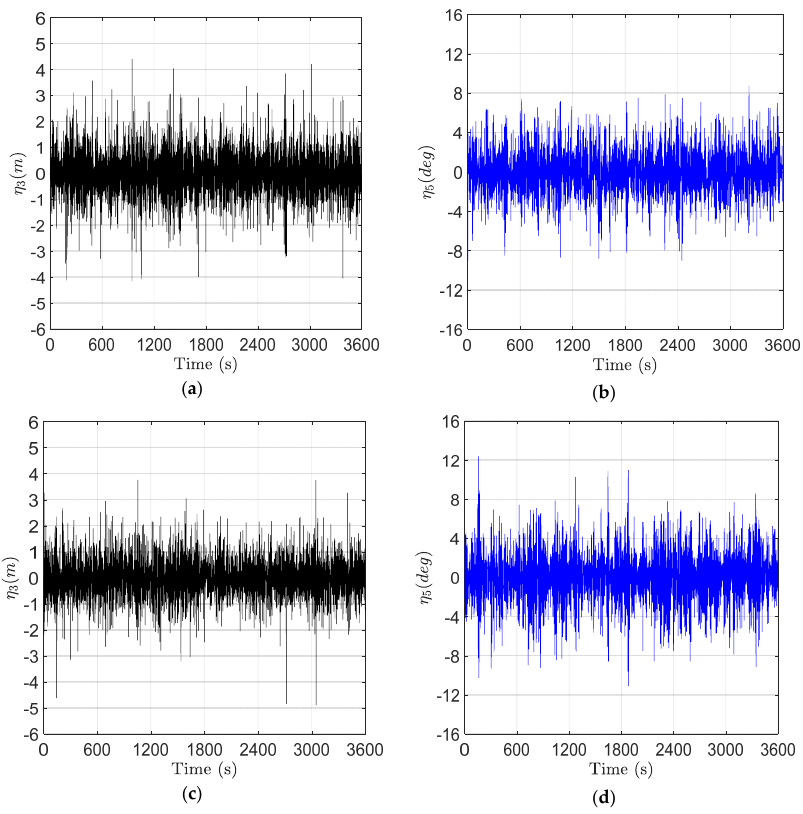
Figure 6. Data collection, motions amplitude: ( a ) Heave—7 January 2020; ( b ) Pitch—7 January